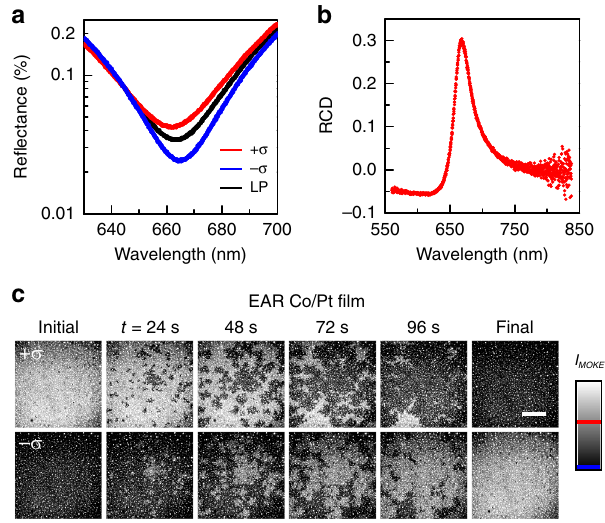
Fig. 5 Analyser-free MOKE microscopy. a Measured re fl ectance spectra of the EAR Co/Pt fi lm under the right- ( − σ ) and left-handed ( + σ ) circularly polarised incidence and the LP incidence. b Spectrum of the RCD. c Measured analyser-free MOKE microscope images of magnetisation reversals of the EAR Co/Pt fi lm under the left- and right-handed circularly polarised illuminations. The red and blue lines in the colour bar indicate the maximal and minimal values of the measured MOKE intensity, respectively. Scale bar, 50 μ